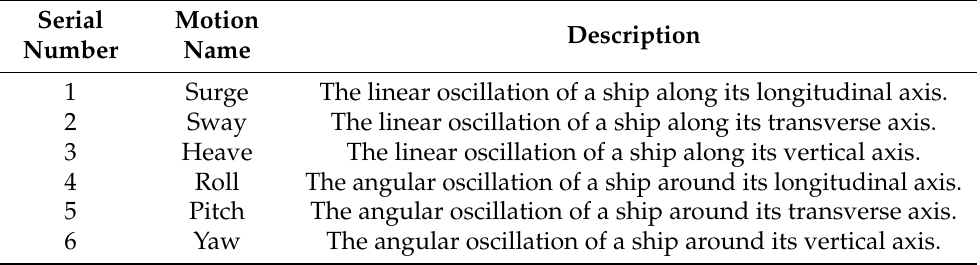
Figure 1. The geometry of a ship’s 6-DOF motion. P is a point target fixed on the ship. The definitions of the ship’s 6-DOF motion is shown in Table 2 [6]. These six motions can be simply classified into two categories, the linear oscillation of a ship along three axes and the angular oscillation of a ship around those three axes. The serial numbers in the table correspond to those in Figure 1. Table 2. Description of 6-DOF oscillatory motion of the ship.